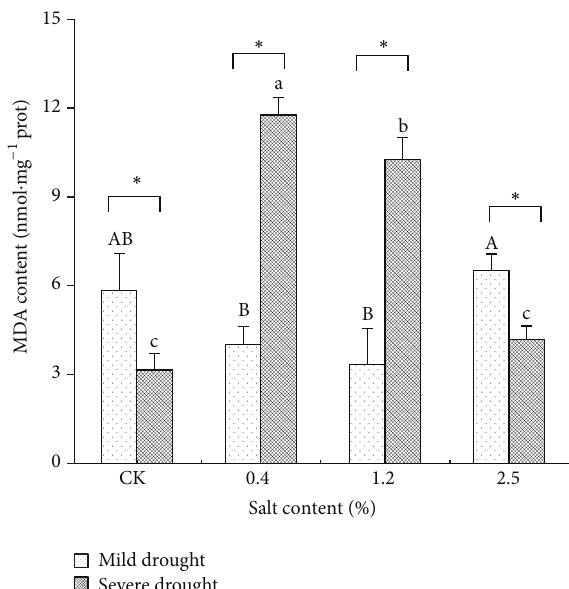
Figure 2: The changes of MDA contents under different salt and drought stresses. The different letters within the same treatment indicate the significant difference at 0.05 level. The “ ∗ ” stands for the significant difference at 0.01 level between two treatment under the same salt